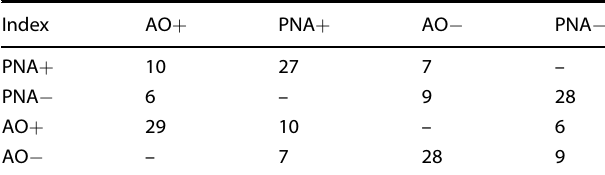
Table 1. Percentage of days with positive or/and negative phases of PNA and AO for indices larger than 0.5 standard deviation from